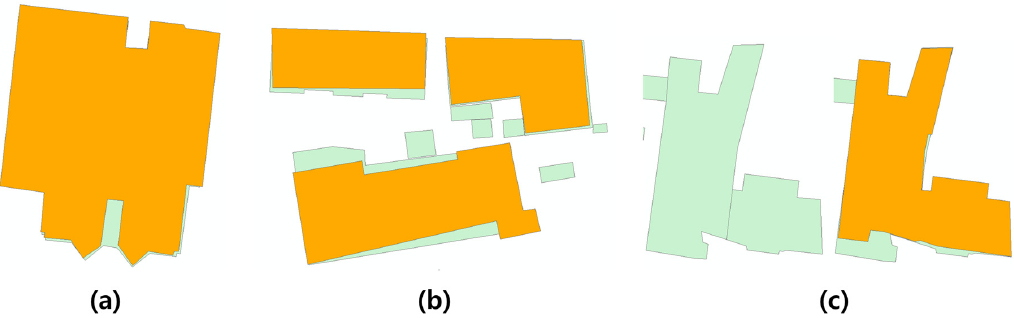
Figure 4. Examples of labeled buildings: ( a ) 0-eliminated; ( b ) 1-retained; ( c ) 2-aggregated (green = 1:1000 scale; orange = 1:25,000 scale).